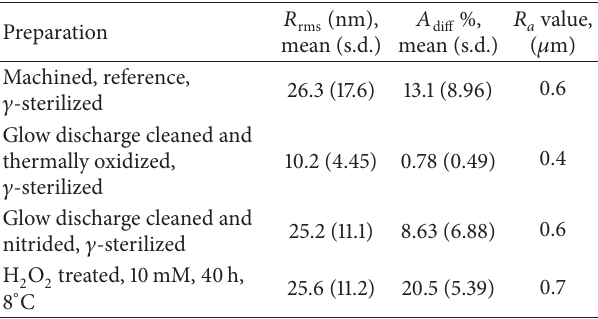
Table 2: Results from AFM (surface roughness (𝑅 ) ), and optical profilometer (𝑅 enlargement (𝐴 diff